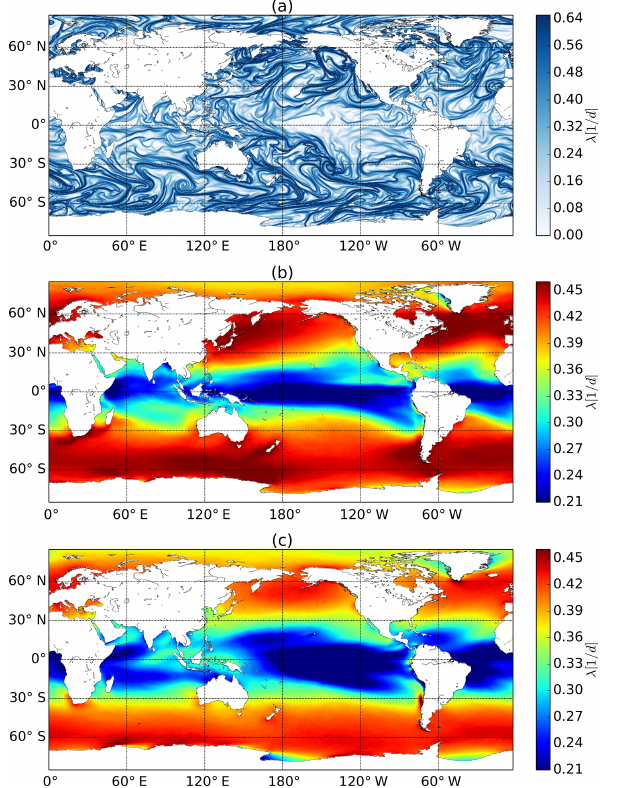
Figure 1. Backward finite-time Lyapunov exponents λ for a given day (a) . Local maxima in the plot (darker colors) are attracting co- herent structures. Mean forward (b) and backward (c) FTLE clima- tology for the 1989–2014 period. For all cases, τ = 5